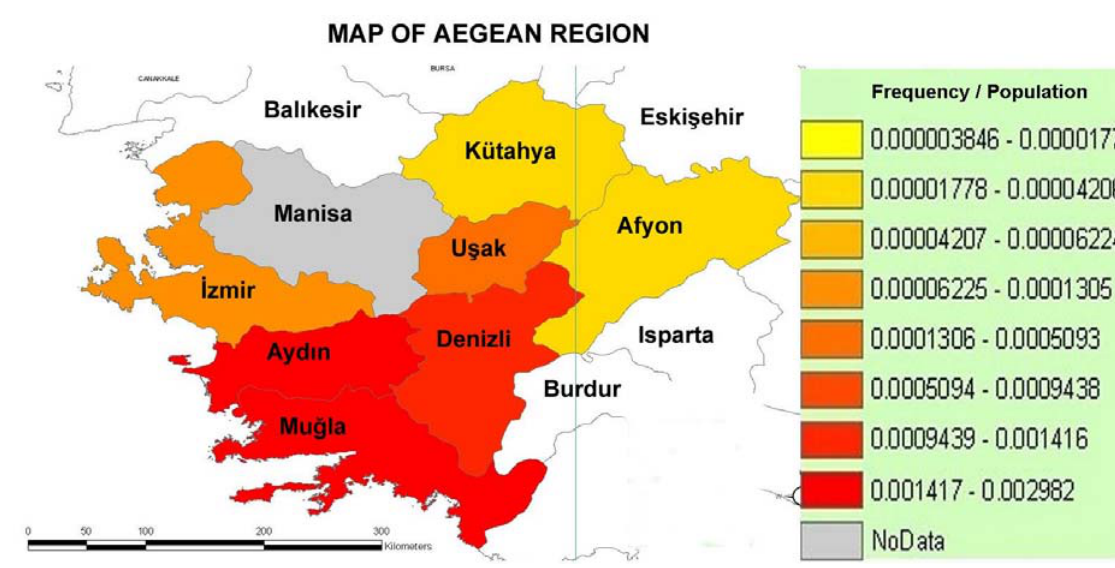
Figure 4. Scorpion stings are responsible for significant morbidity in Mugla, Ayd ı n and Denizli Provinces of the Aegean